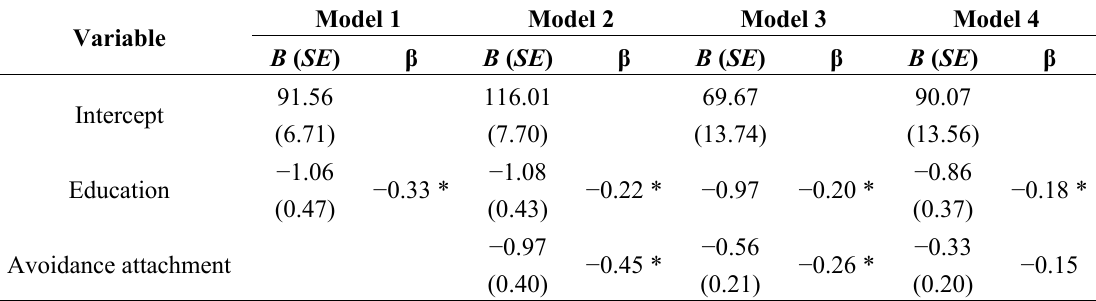
Table 4. Hierarchical Multiple Regression Models for Predicting PTSD Severity after 12